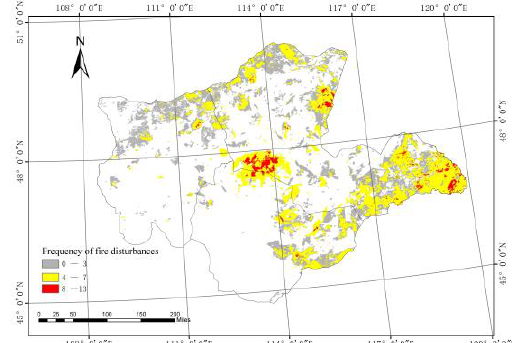
Figure 2.The Spatial Distribution of Fires (b) frequency of fire disturbances